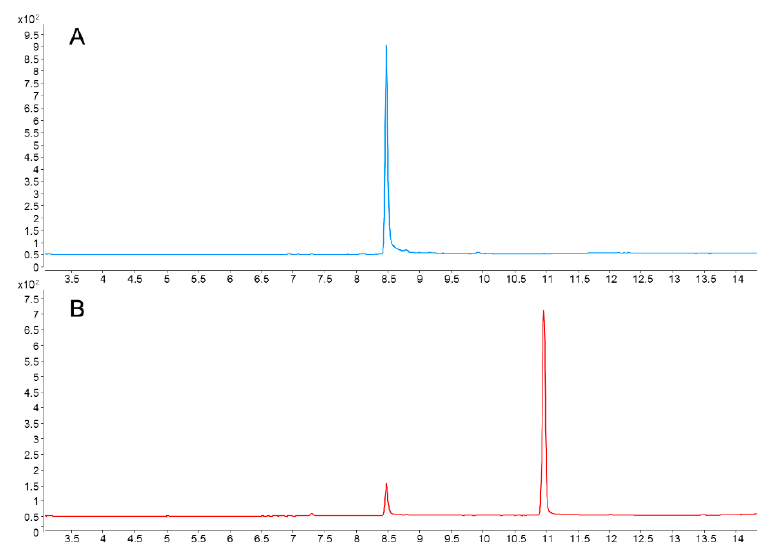
Figure 3. The GC-MS chromatograms of acetochlor (A, m/z = 146) and butachlor (B, m/z = 176) standards in selected ion monitoring (SIM) mode.